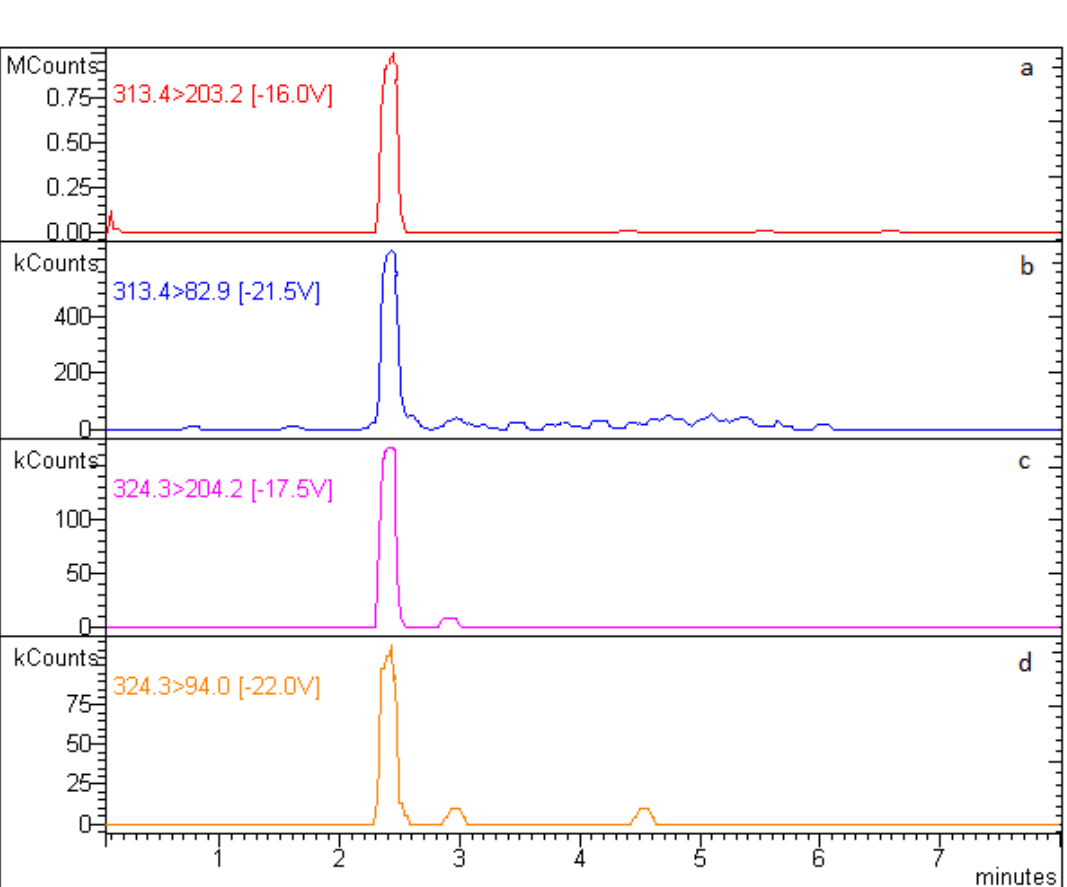
Table 3. Matrix effect, recovery and precision.